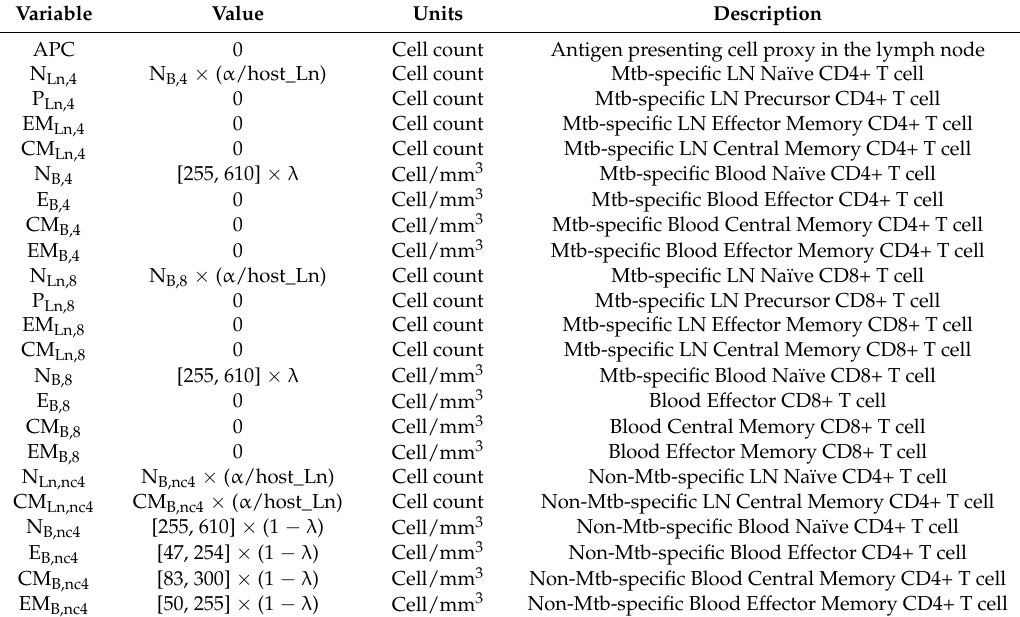
Table 1. Initial conditions. These values are based on the experimental data collected and published in our previous work [36]. The values and references for the scaling parameters (i.e., α , λ and host_LN (lymph node)) are given in Appendix